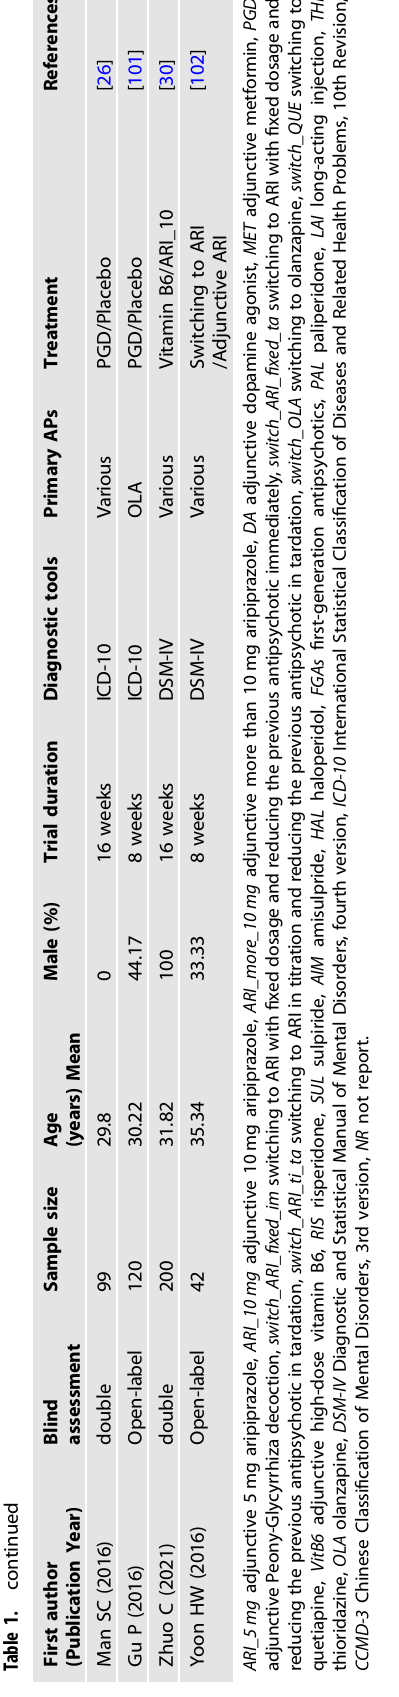
publication bias (Supplementary Fig. 3A, t = 0.01, df =